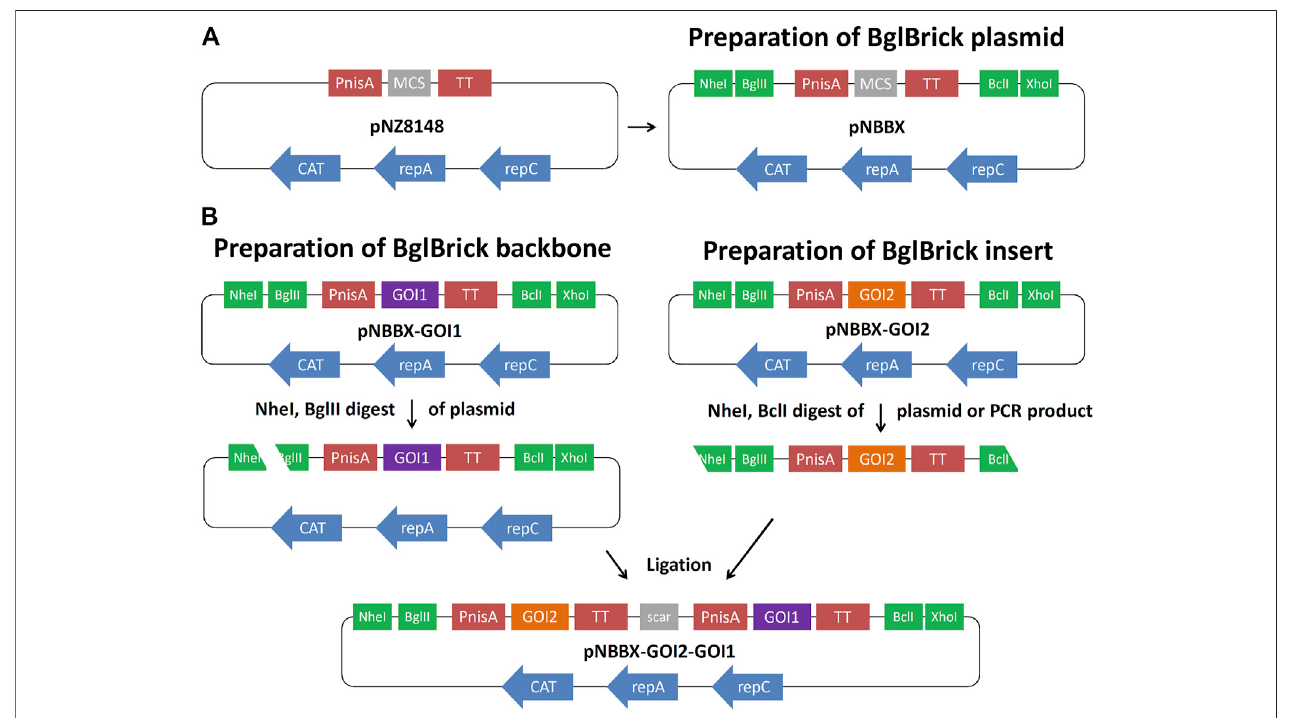
FIGURE1| PreparationofBglBrickplasmidpNBBXbyinsertionofNheI/BglIIandBclI/XhoIsitesintopNZ8148 (A) .ExampleofupstreamBglBrickcloningofagene cassetteusing NheI/BglII for thebackbone and NheI/BclI for the insert and exploiting BglII/BclI complementarity resulting in ascar (B) .GOI,gene ofinterest; PnisA, nisin promoter; TT, transcription terminator; MCS, multiple cloning